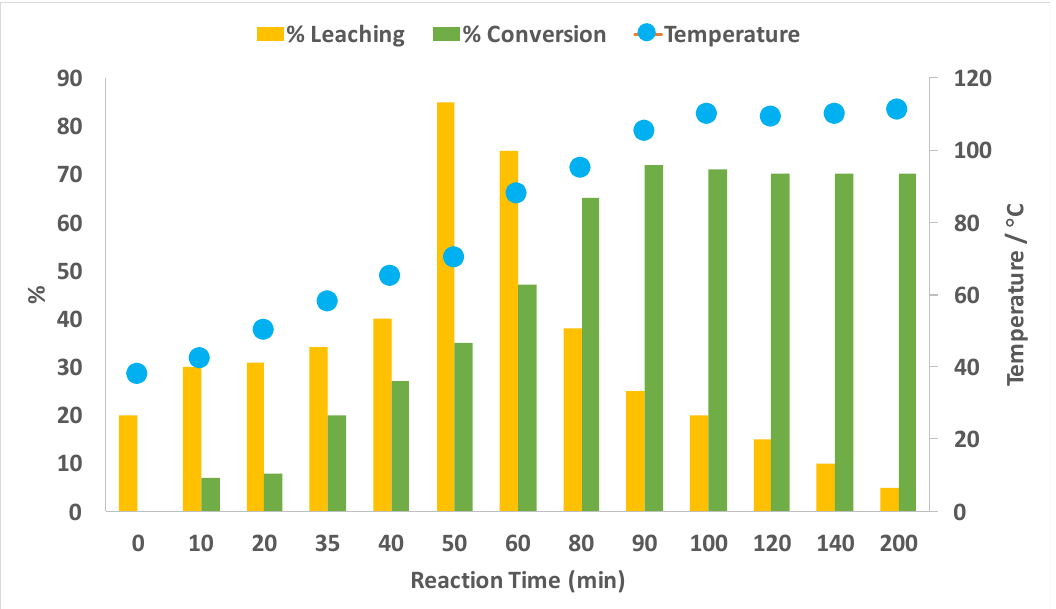
Figure 2. Time ‐ dependent correlation of palladium leaching with the progress of the reaction [38] (Adapted with permission from John Wiley and Sons).